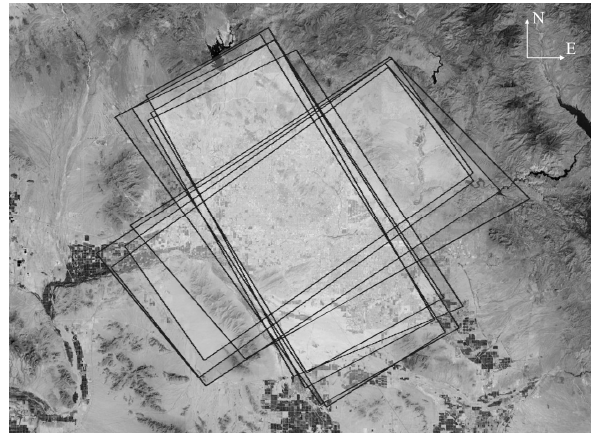
Figure 2. Layout of imagery routes of the geometric calibration range for adjustment of interior orientation